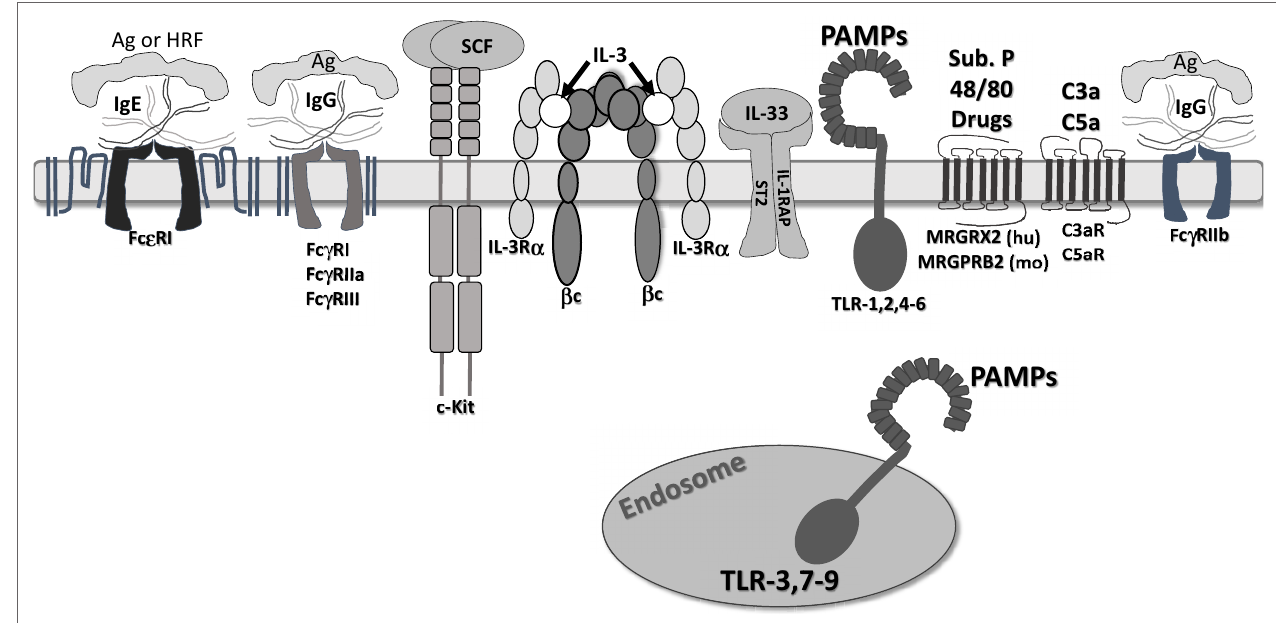
FiGURe 1 | Receptors that regulate mast cell function. The receptors shown are confirmed to regulate mast cell function. They are depicted at approximate scale. All except Fc γ RIIb are known to induce mast cell degranulation and/or cytokine secretion. Fc γ RIIb activates SHIP-1 and SHP-1, suppressing inositol and tyrosine kinase activity. c-Kit is a weak mast cell activator, but augments signals by other receptors. IL-3 receptor is modeled after work by Broughton et al. (20). Note that ligands for Mas-related G protein-coupled receptor-X2 (MRGPRX2)/B2 are not fully known, but include drug classes discussed in the accompanying text. In addition, we do not show “cytokinergic” IgE molecules. These form aggregates in the absence of antigen and elicit Fc ε RI signaling.